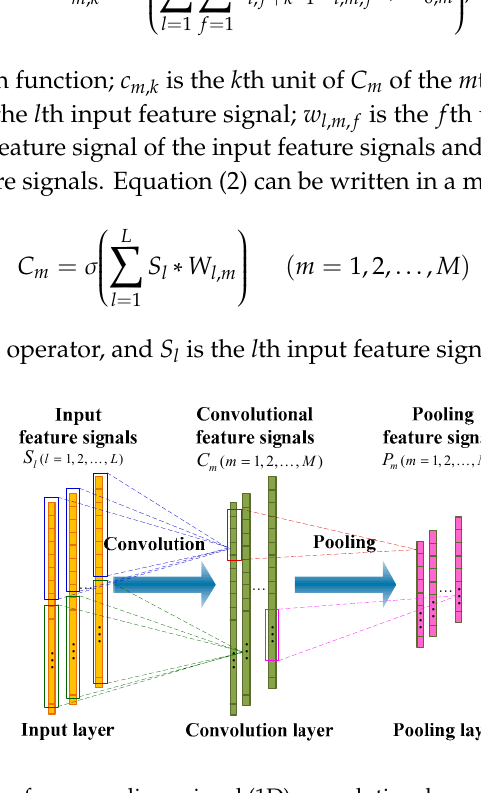
Figure 4. An illustration of one one-dimensional (1D) convolutional neural network (CNN) consisting of a convolution ply and a pooling ply.